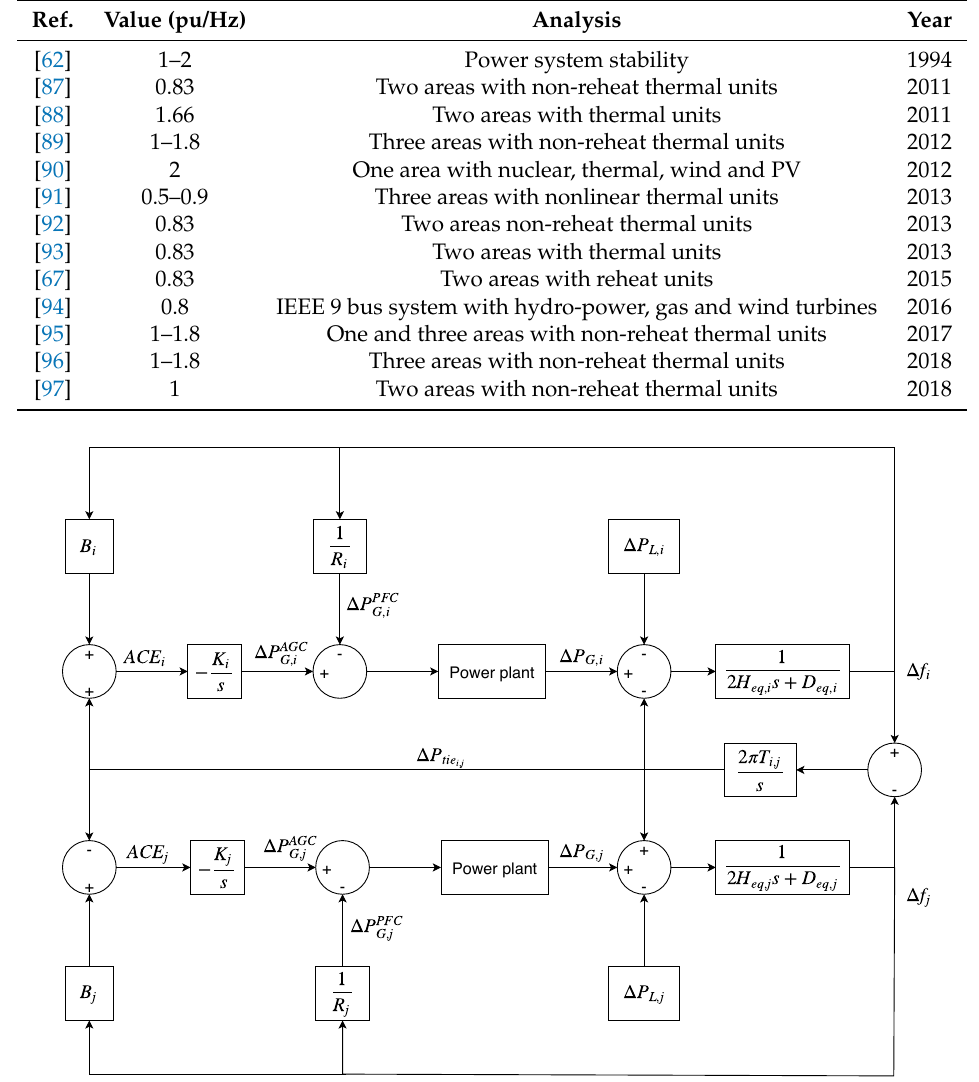
Table 6. Damping factor values.